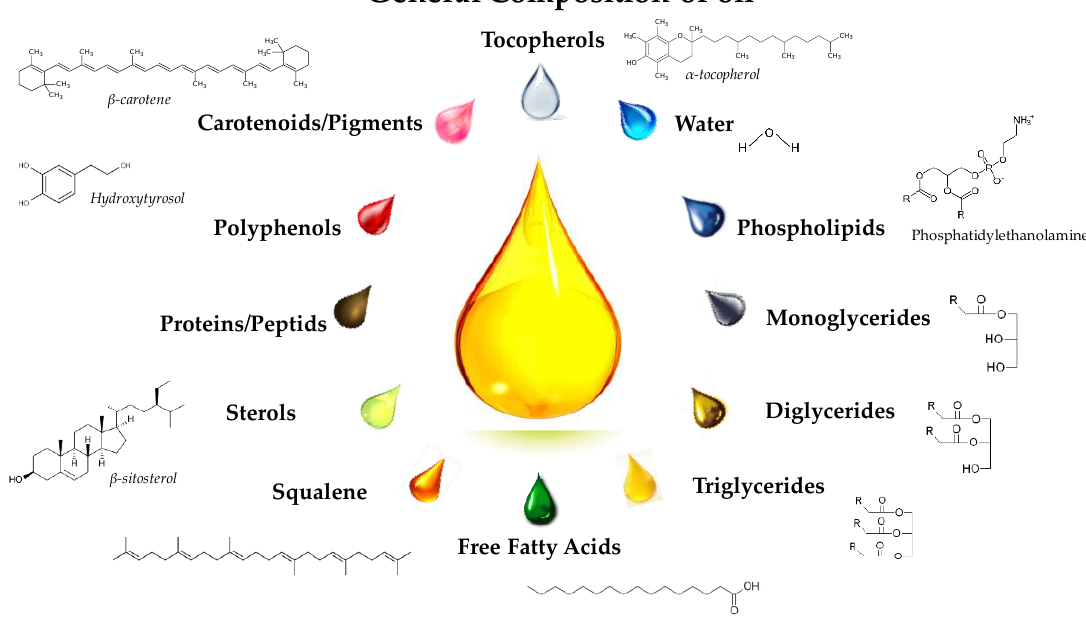
Figure 2. Minor components in vegetable oils.